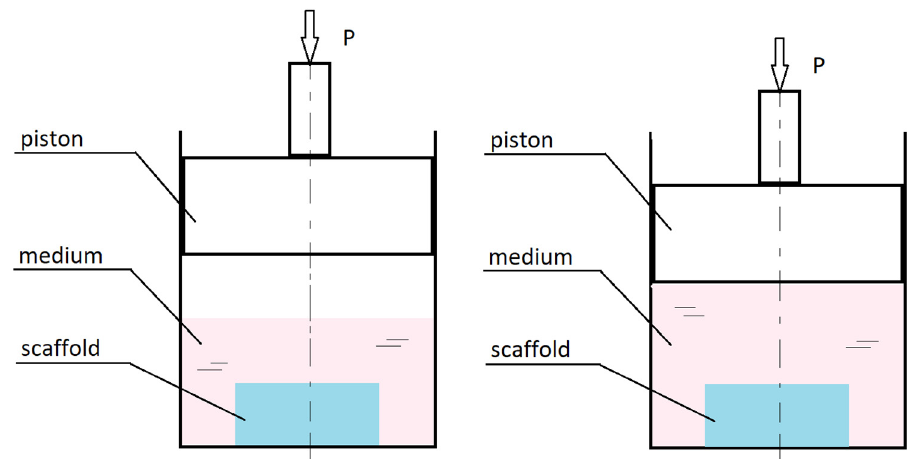
Figure 5. Diagram showing how intermediate pressure loads work in culture bioreactors.